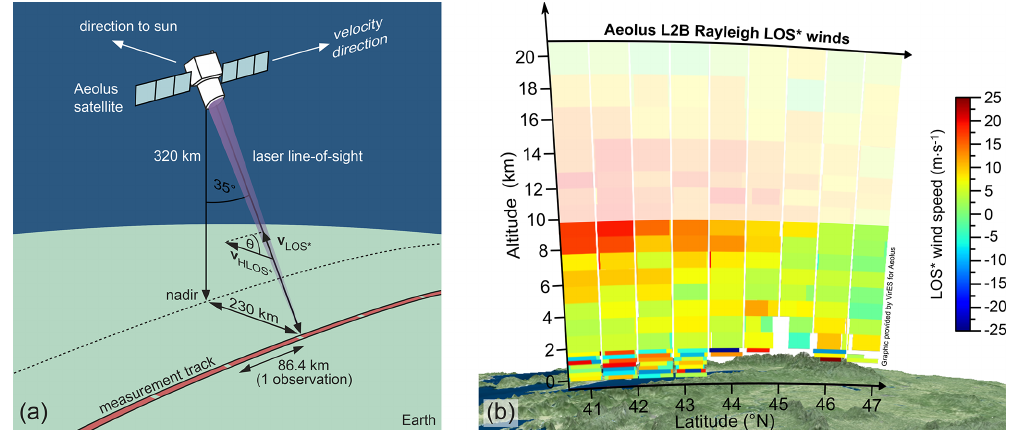
Figure 5. (a) Aeolus observational geometry, and (b) Aeolus L2B LOS* Rayleigh winds (positive if winds are blowing away from the instrument) measured during the underflight on 22 November 2018 between 40.6 and 47.2 ◦ N. Only winds with an estimated wind error of less than 12ms − 1 are shown. Winds at altitudes above 10km are outside of the measurement range of the A2D and are consequently greyed out. The figure was created based on a screenshot from the Aeolus data visualization tool, © VirES for Aeolus (https://aeolus.services/, last access: 25 November 2019).